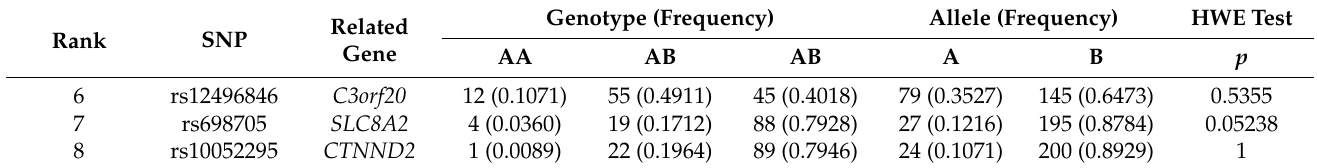
Table 1. Genotype DISTRIBUTIONS of the three candidate SNPs in PATIENTS who underwent major open abdominal SURGERY.